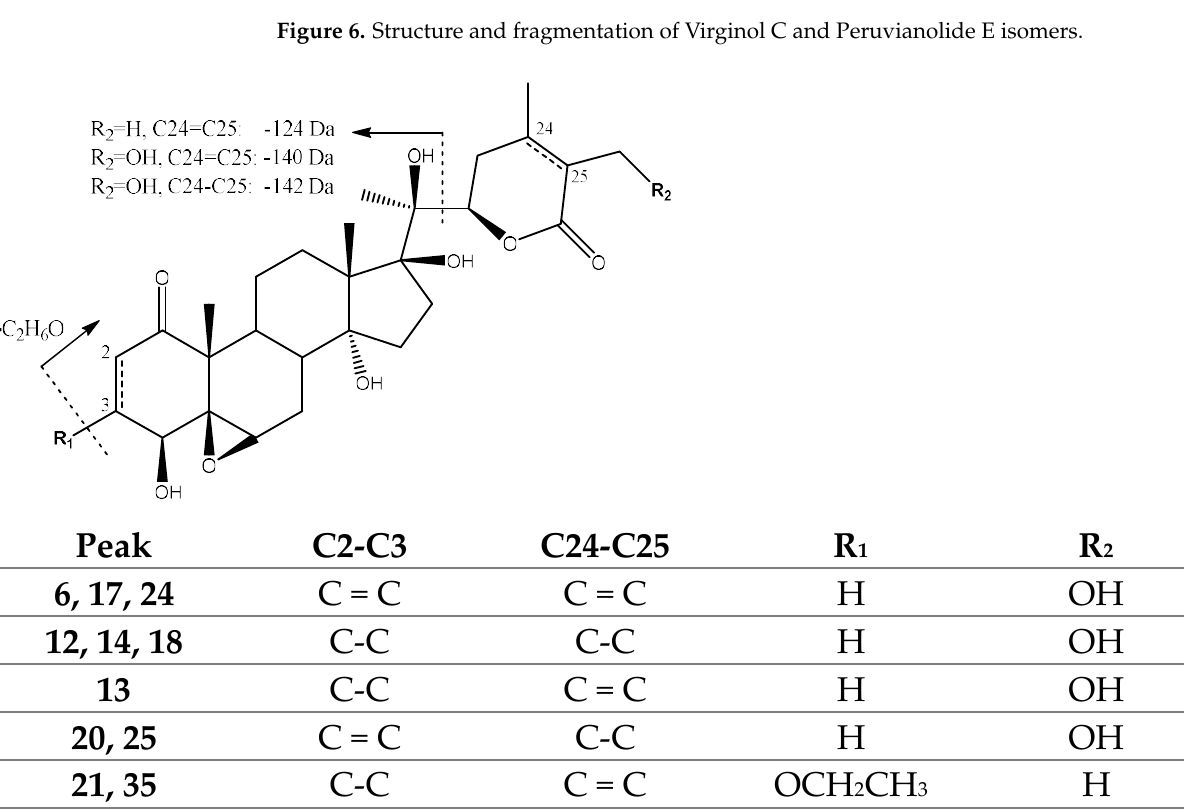
Figure 7. Structure and fragmentation of withanolide E derivatives hydroxylated in C-27. Another type of withanolide E was present in peak 4 (Rt = 14.91 min) with [M-H] − at m / z 543.2612 (C 30 H 39 O 9 ), which was tentatively assigned to the previously described Physagulin O [32] (Figure 8), with fragments at m / z 483 due to the loss of the acetoxy group ( − 60 Da) and m / z 359 from the loss of lactone (124